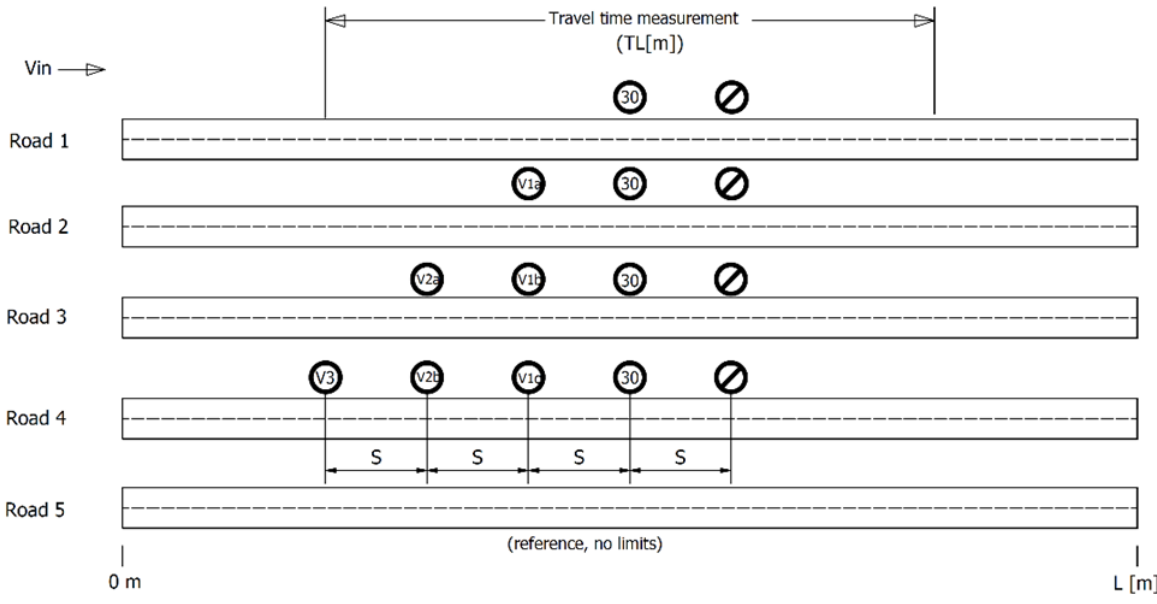
Figure 2. The model of road sections adopted in the travel time simulation.